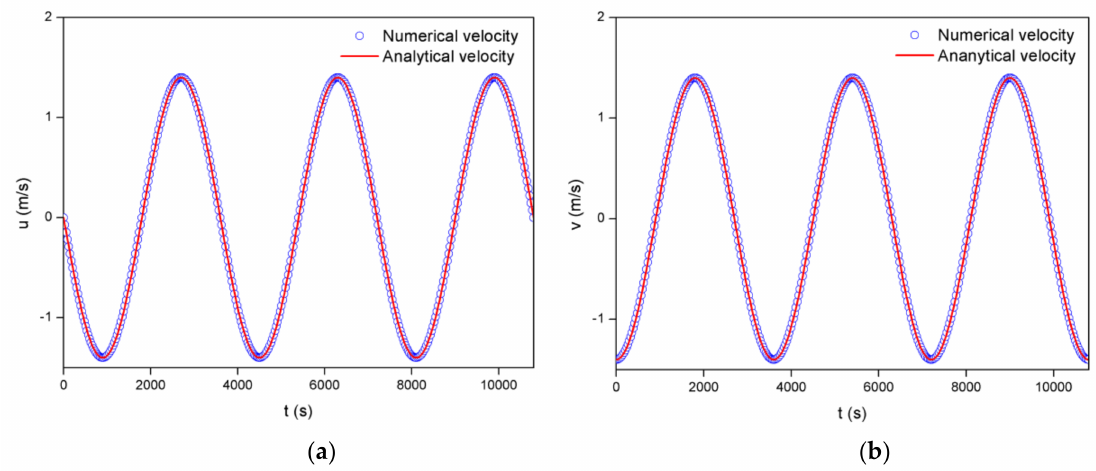
Figure 12. Comparison between simulated and analytical velocities for the mesh of ∆ L = 55.18 m at the point ( − 5000, − 100): ( a ) u velocity; ( b ) v